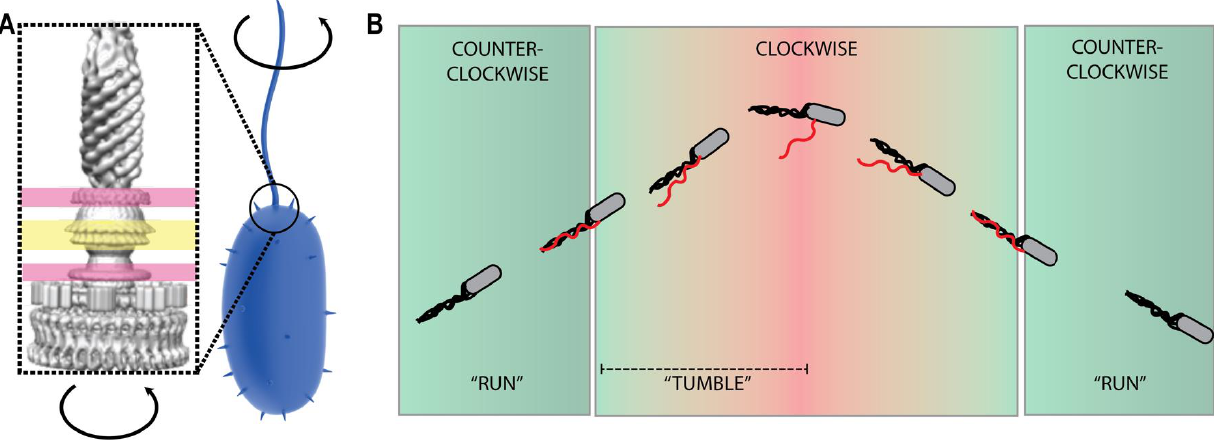
FIGURE 1: Schematic diagram of the bacterial flagellar motor (BFM). (A). (left) Cryo-Electron microscopy tomography of the basal body (rotor) of the flagellar motor showing embedded in the inner and outer membrane (pink) and the peptidoglycan layer (yellow) Tomogram from [14]. (right) The motor rotates the filament which drives bacterial propulsion. (B) Bacterial motility exhibiting ‘Run and tumble’ dynamics. Counter- clockwise rotation of all BFMs correlates to a bacterial run, whereas clockwise rotation leads bacteria to tumble. Dynamics of filament confor- mational transitions and bundling are described in